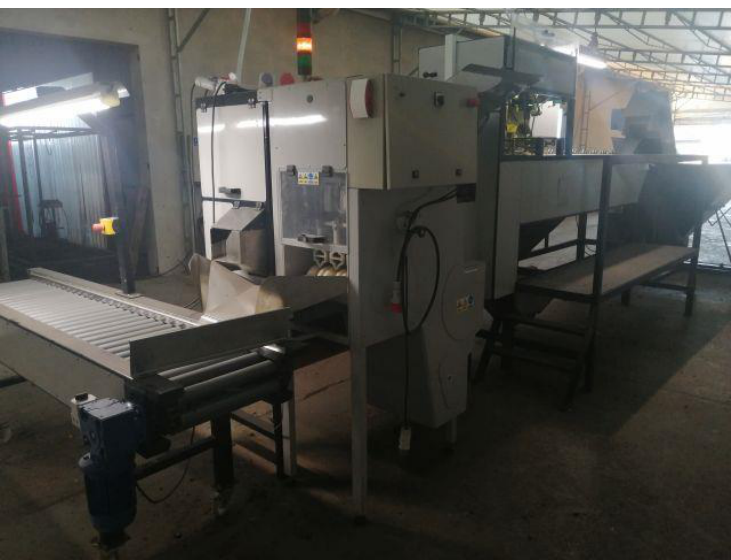
Figure 2. Main test bed: modular machine for peeling onions (left-hand side view).